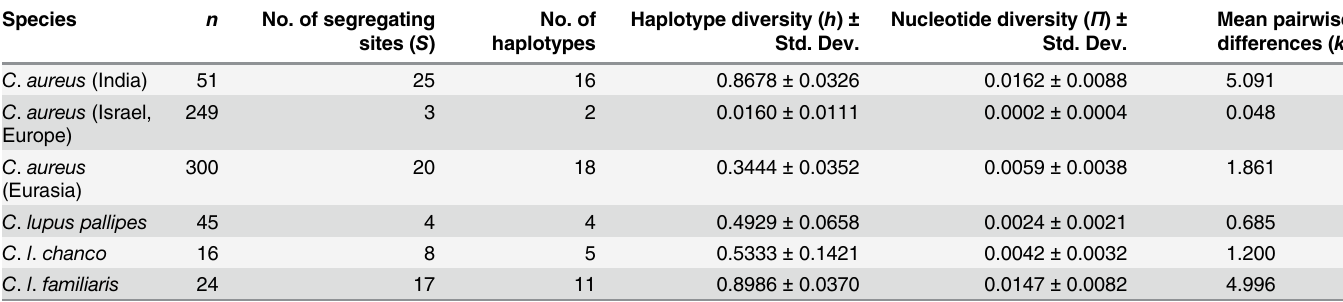
Table 4. Summary statistics of molecular diversity at mtDNA control region in golden jackal and related Indian